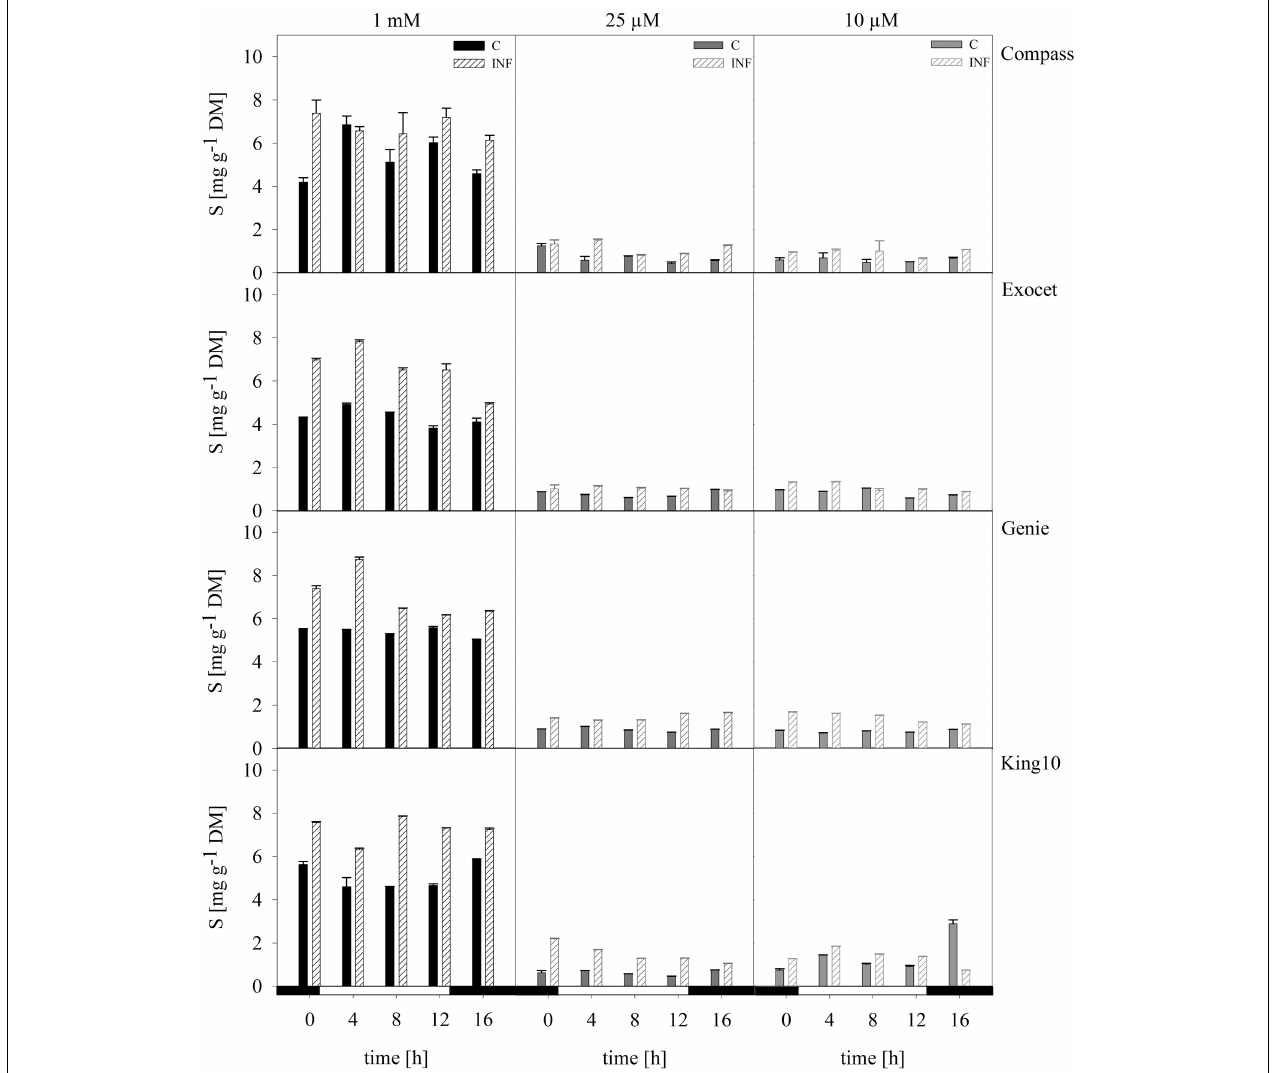
FIGURE 5 | Elemental sulfur. The elemental sulfur was measured in dried plant material by ICP-OES. Seven-day-old seedlings of the cultivars were mock-inoculated or infected with V. longisporum spores. Plants were grown under full sulfur supply (1mM MgSO 4 ) and under sulfur limitation (0.025mM and 0.010mM MgSO 4 ) in a climate chamber for 14 dpi. Three plants with five leaves fully expanded per treatment were